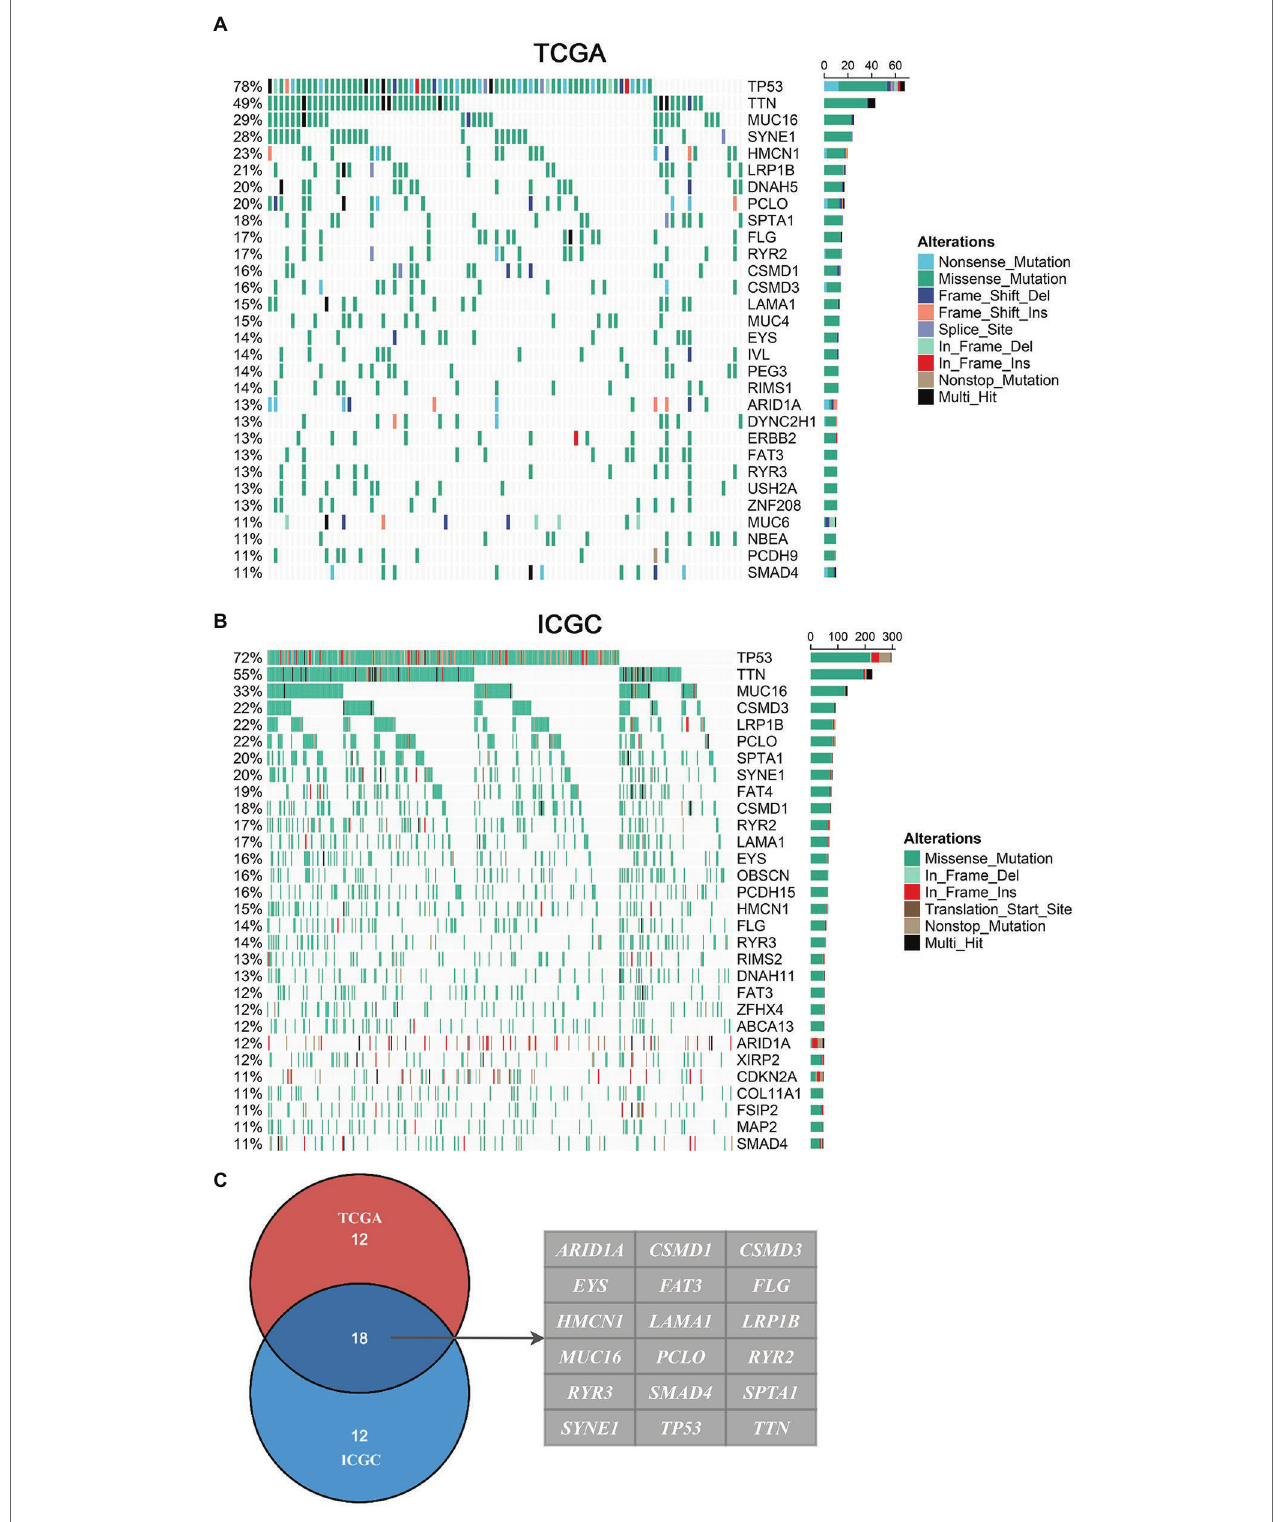
FIGURE 1 | Landscapes of frequently mutated genes (FMGs) in esophageal adenocarcinoma (EAC). (A,B) Oncoplot depicts the FMGs of EAC in The Cancer Genome Atlas (TCGA; A ) and International Cancer Genome Consortium (ICGC; B ) cohorts. The left panel shows mutation rate, and genes are ordered by their mutation frequencies. The right panel presents different mutation types. (C) Venn diagram of FMGs covered by both TCGA and ICGC